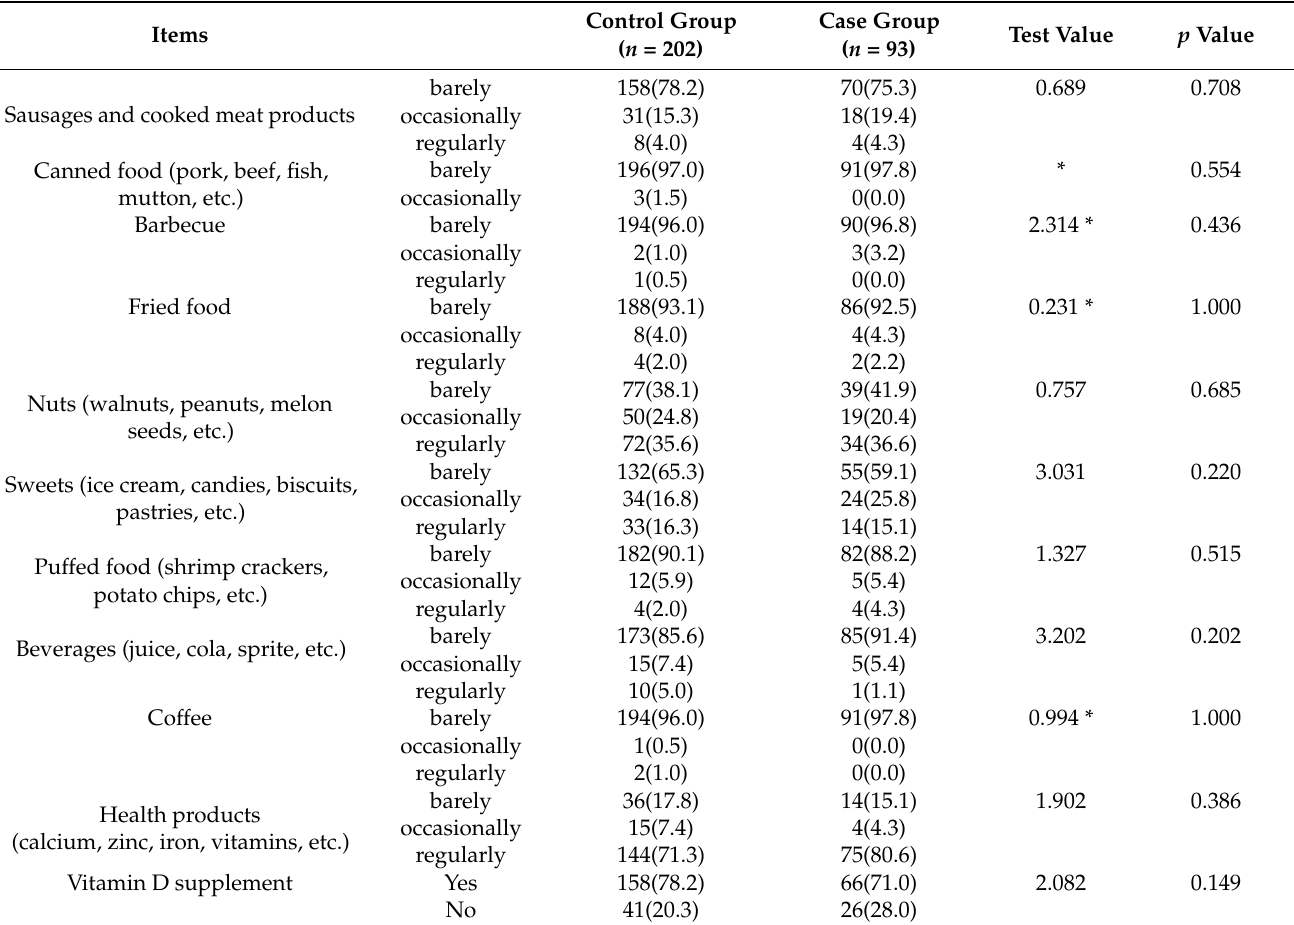
Table 7. Comparison of the snack intake frequencies of women during pregnancy between the control and case groups ( n , %).